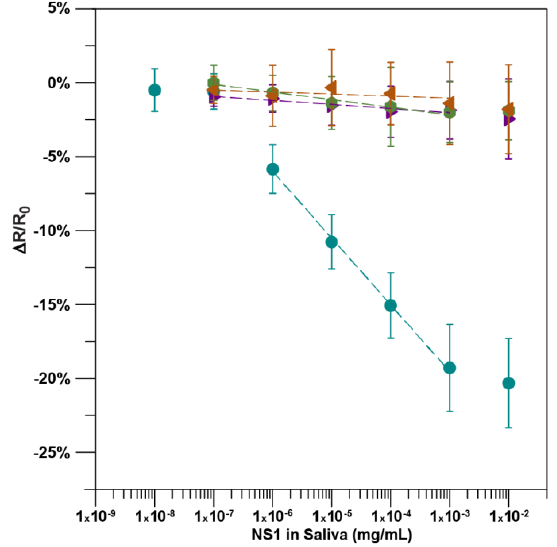
Figure 3. Immunosensor calibration plot: normalized response of the immunosensors functionalized with BSA, Tween-20, and anti-NS1 antibody after incubation with NS1 protein in artificial human